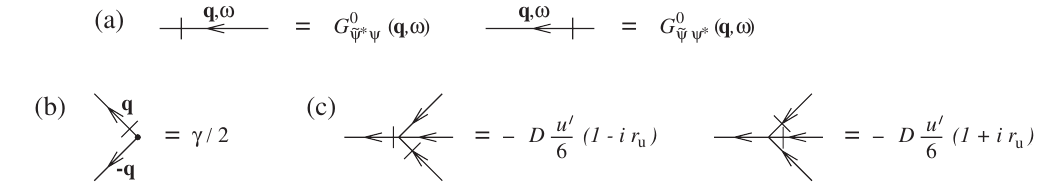
FIG. 1. Elements of the diagrammatic perturbation expansion. (a) Bare retarded and advanced propagators [Eq. (21)], where the arrows reflect the causal temporal flow from ψ to ~ ψ fields, while the perpendicular bars indicate complex conjugation, (b) two-point noise vertex, and (c) four-point relaxation vertices (note that vertex functions are depicted with truncated external